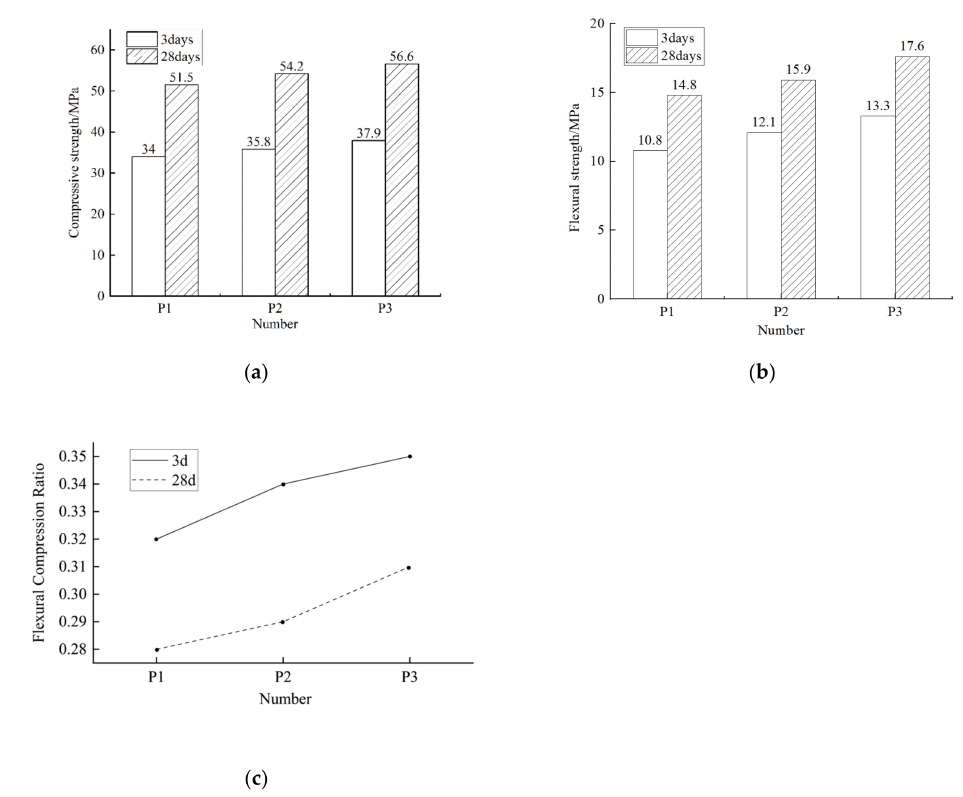
Figure 5. Mechanical property curve of ECC prepared with different types of fly ash: ( a ) compressive strength; ( b ) flexural strength; ( c ) flexural compression